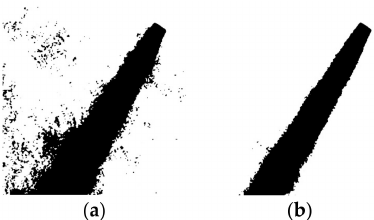
Figure 5. Binary-mask filter: resulting powder flow for different intensity thresholds (carrier = 4.51e − 0.5 kg/s; shielding = 2.92e − 0.4 kg/s; powder feed rate = 0.14 g/s): ( a ) intensity threshold of 206; ( b ) intensity threshold of 198.